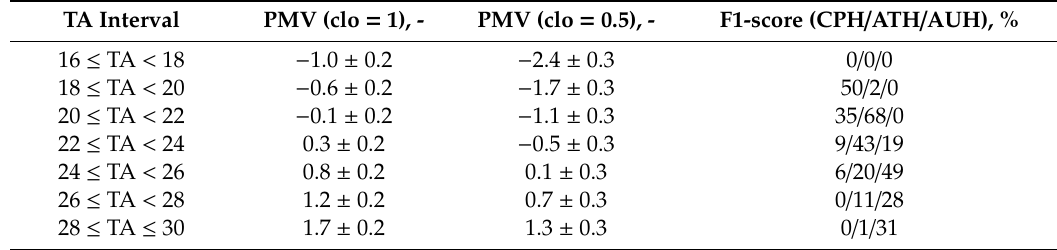
Table 8. Estimation of the Predicted Mean Vote index (PMV) depending on the TA interval taken into account. TA Interval PMV (clo = 1), - PMV (clo = 0.5), - F1-score (CPH / ATH / AUH),